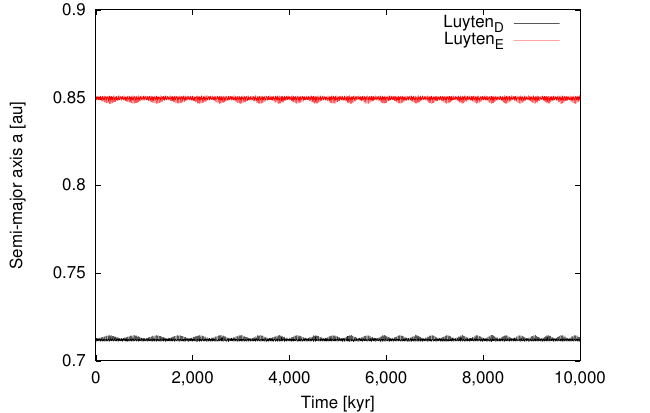
Figure 6. Case 5 ( e D = 0.017, e E = 0.003). Time evolution of the two outer planets over 10 Myr. This is the most stable